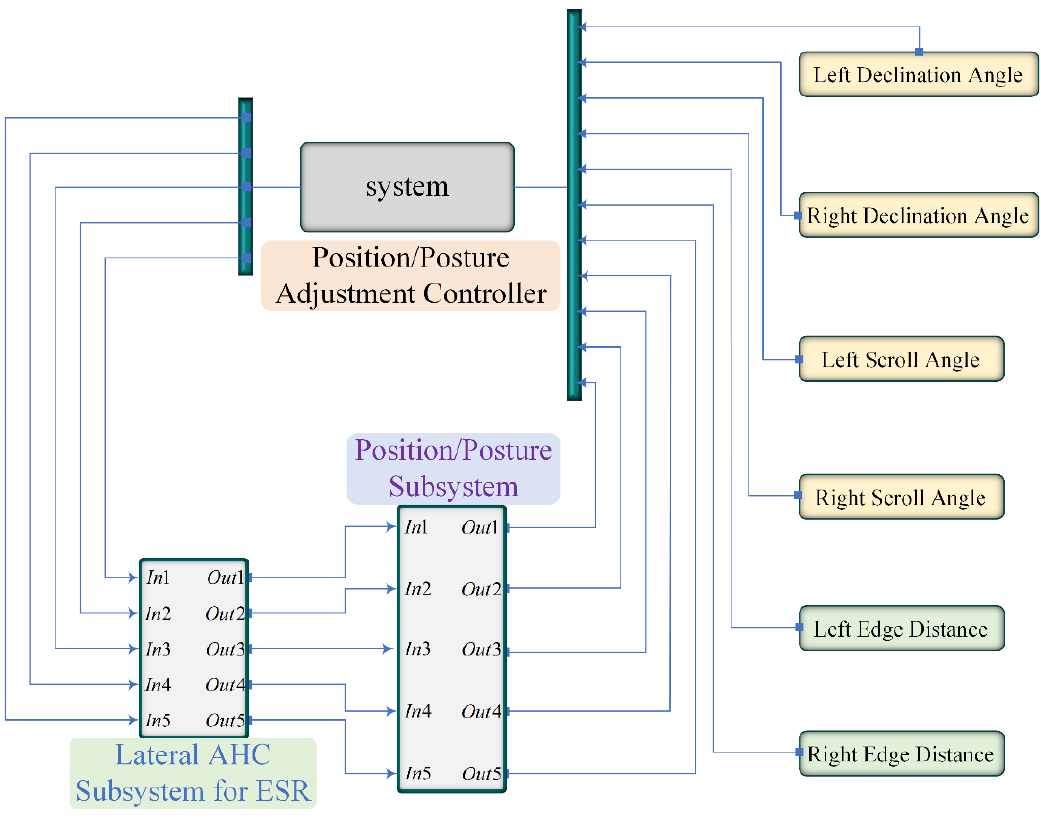
Figure 11. Simulink model of the desired position/posture adjustment control system.